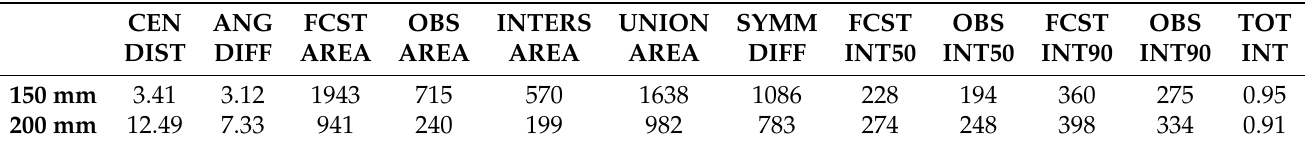
Table 2. WRF-OL forecast validation through the MODE